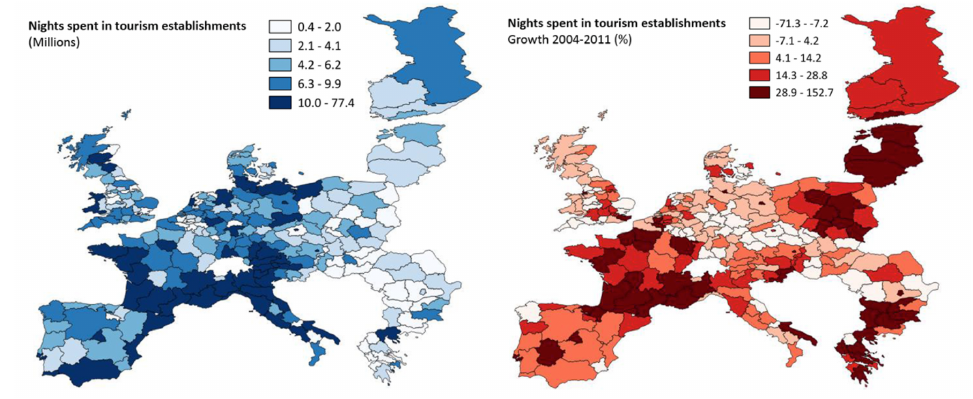
Figure 1: Regional tourism